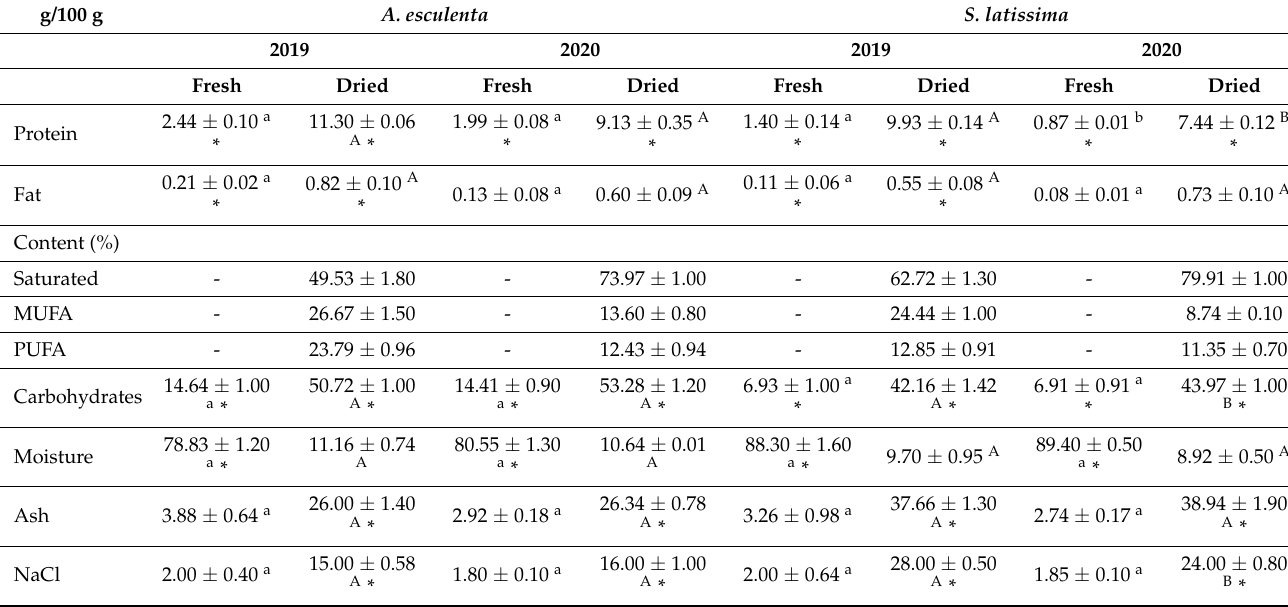
Table 2. Nutritional parameters of fresh and dried seaweeds A. esculenta and S. latissima in 2019 and 2020 harvest years. g/100